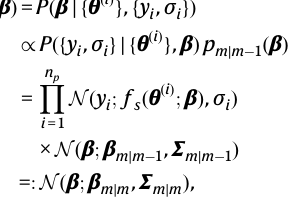
Fig. 7 | Operations used within the Fermi-Hubbard VQE circuit. From top to bottom, Givens rotations,hopping terms,onsite terms, fermionic swaps, and basis changes for hopping term measurement — and how they can be decomposed in